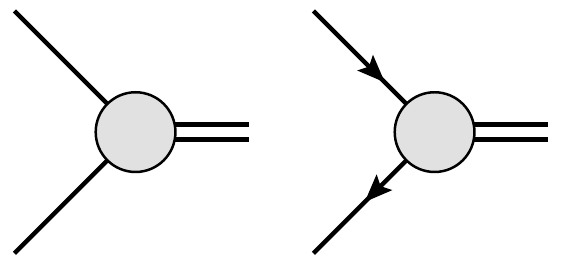
Figure 15 . The amplitudes for the transition from a pair of neutral winos or a pair of charged winos to the wino-pair bound state. The bound state ( ww ) is represented by an external solid double line. The Feynman rules for these amplitudes are (cid:0) i Z 1 = 2 Z 0 and Z 1 are the residue factors given in eqs.